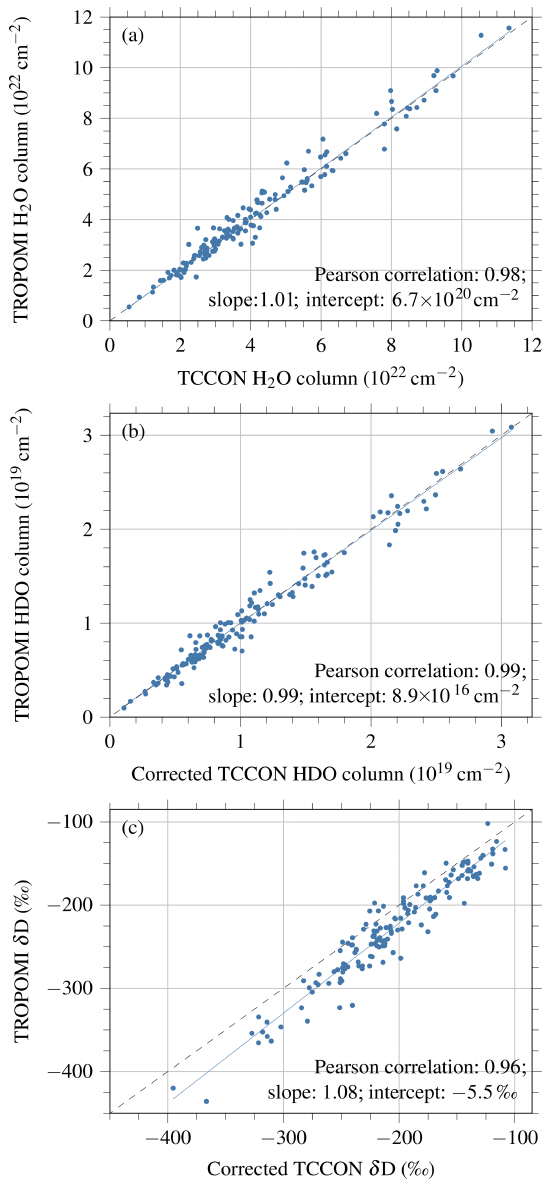
Figure 6. Correlation plot of corrected TCCON measurements and co-located TROPOMI observations for Edwards station for daily averages of H 2 O columns (a) , HDO columns (b) and δ D (c) . The dashed lines mark equality, and the solid lines give linear fits to the data.